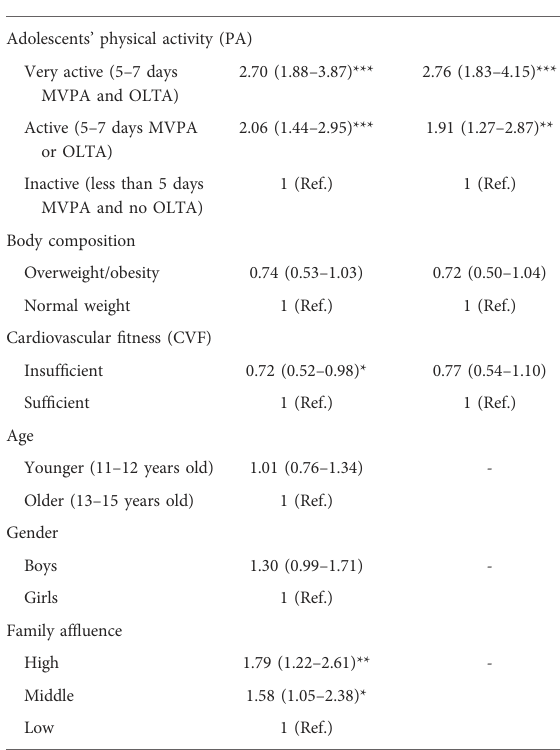
TABLE 1 Characteristics of the sample ( N =888, 11 – 15-years-old Slovak school-aged children, data collected in 2018). Characteristic